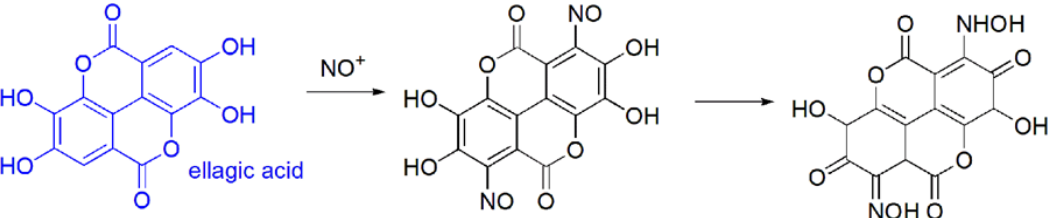
Figure 6. A hypothesized EA in vivo reaction. Figure 5. A hypothesized EA in vivo reaction.